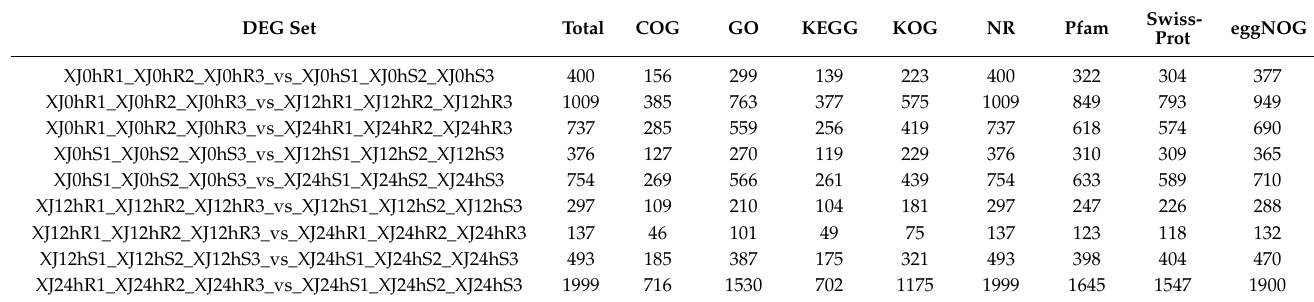
Table 8. Annotated statistics on the number of differential miRNA target